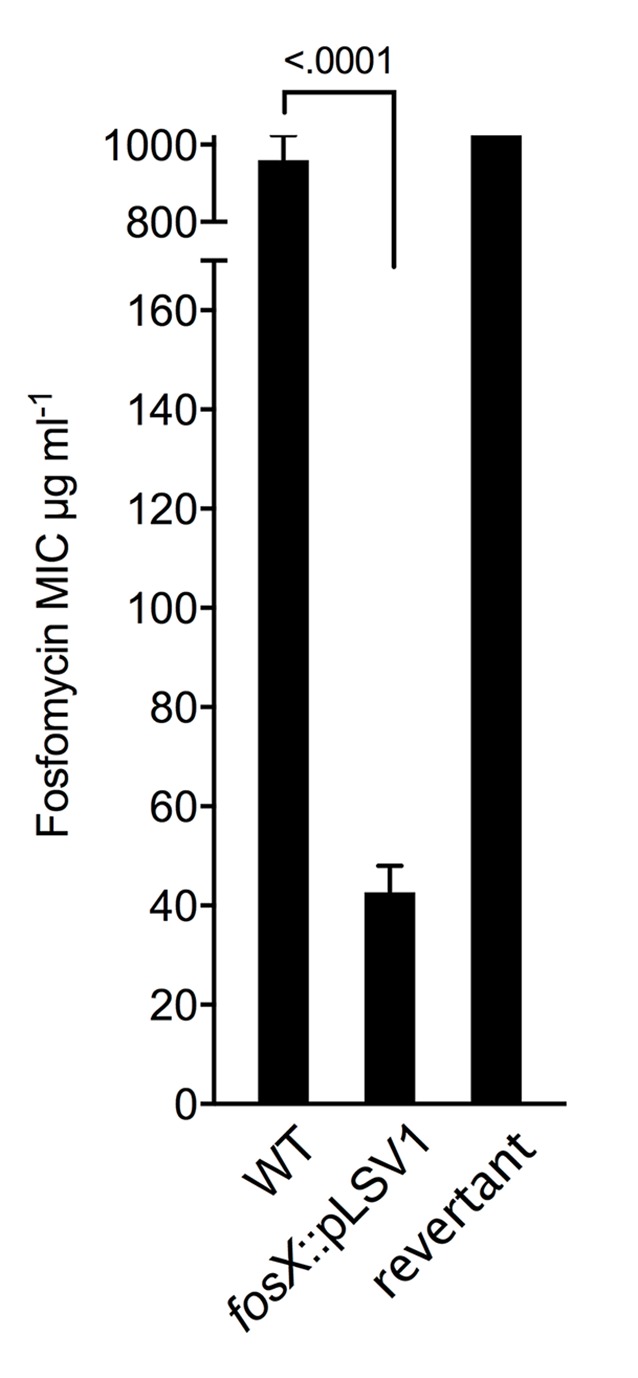
fosX confers intrinsic fosfomycin resistance to non-pathogenic Listeria.L. innocua strain CLIP 11262 was used as representative obligate saprotrophic Listeria sp. Data for wild type, fosX knock-out mutant by pLSV1 plasmid insertion, and revertant thereof in BHI. Identical results were obtained in BHI-Ads. Mean ± SD from three experiments. Relevant P values are indicated (One-way ANOVA with Dunnett’s multiple comparisons).